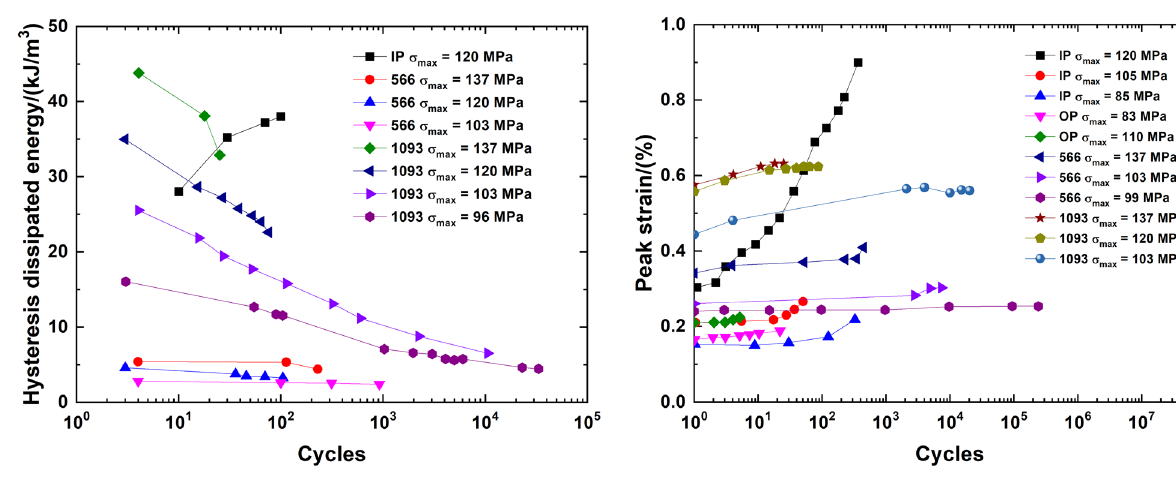
Figure 12: Evolution of FHDE versus applied cycle of cross - ply SiC/ MAS composite under IP - TMF and IF loading.